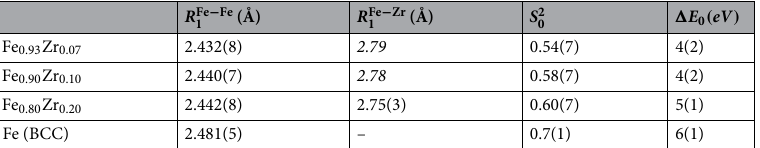
Table 4. The parameter values obtained from the EXAFS fits that are different for each sample. The R values for Fe 0.93 Zr 0.07 and Fe 0.90 Zr 0.10 were fixed to those reported in Table 2 (written here in italic). The Fe-film data are fitted with a BCC structure in the range R = 1.8 − 4.9 Å (non-phase corrected) using a Hanning window.